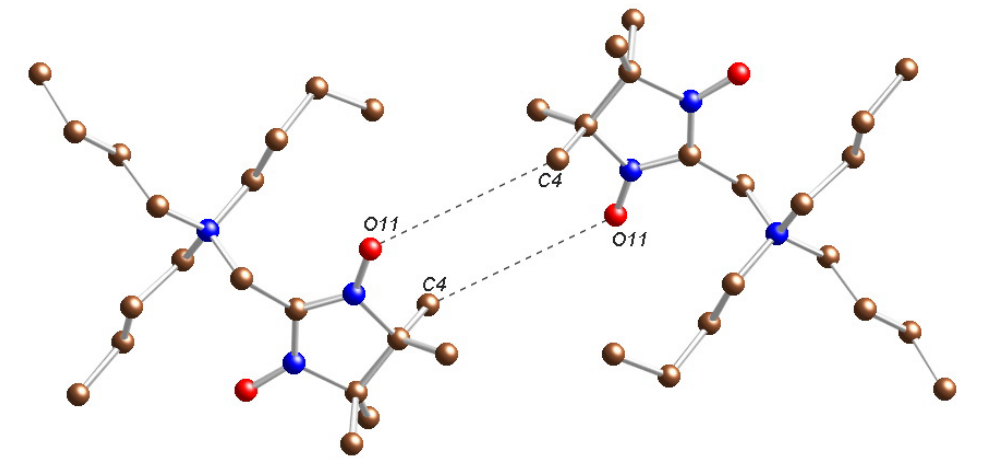
NCH NN dimer. 3 2